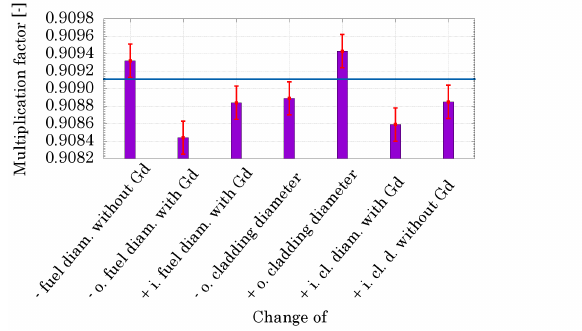
Figure 13. Effect of operational uncertainties on multiplication factor - only with uncertainty included in fuel depletion